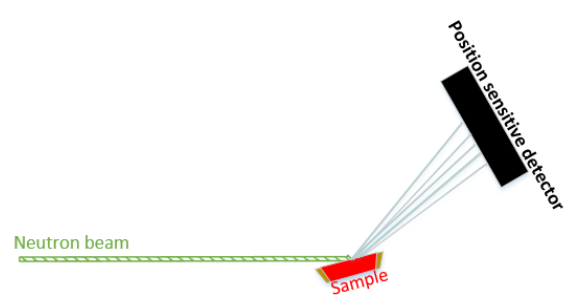
Fig. 3 . Nanodiamond scattering process in Geant4. Fig. 4 . Scheme of CN quasi-specular reflection experimental